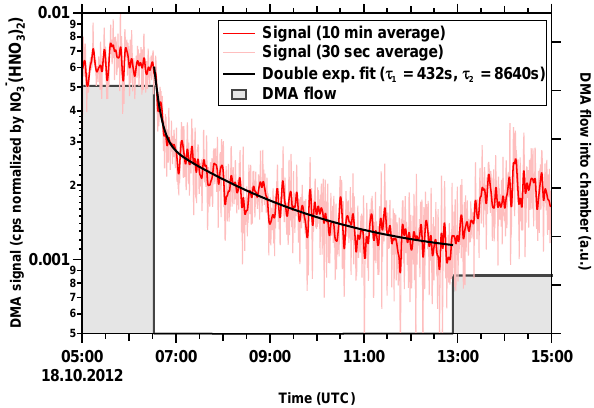
Figure 3. Decay of the normalized cluster ion signal indicating the DMA concentration with 10min time resolution (red line) and 30s time resolution (light red line). The DMA flow (grey line and area) into the chamber is shut off at ∼ 6:32UTC and turned on again (at a lower set point) around 12:54UTC. Using a double-exponential fit (black line) the decaying signal can be well represented. The first inverse decay constant represents the wall loss rate (1 /τ 1 = 2 . 3 × 10 − 3 s − 1 ) , while the second decay (1 /τ 2 = 1 . 2 × 10 − 4 s − 1 ) represents a source term due to slow re-evaporation of DMA from the chamber walls superimposed by